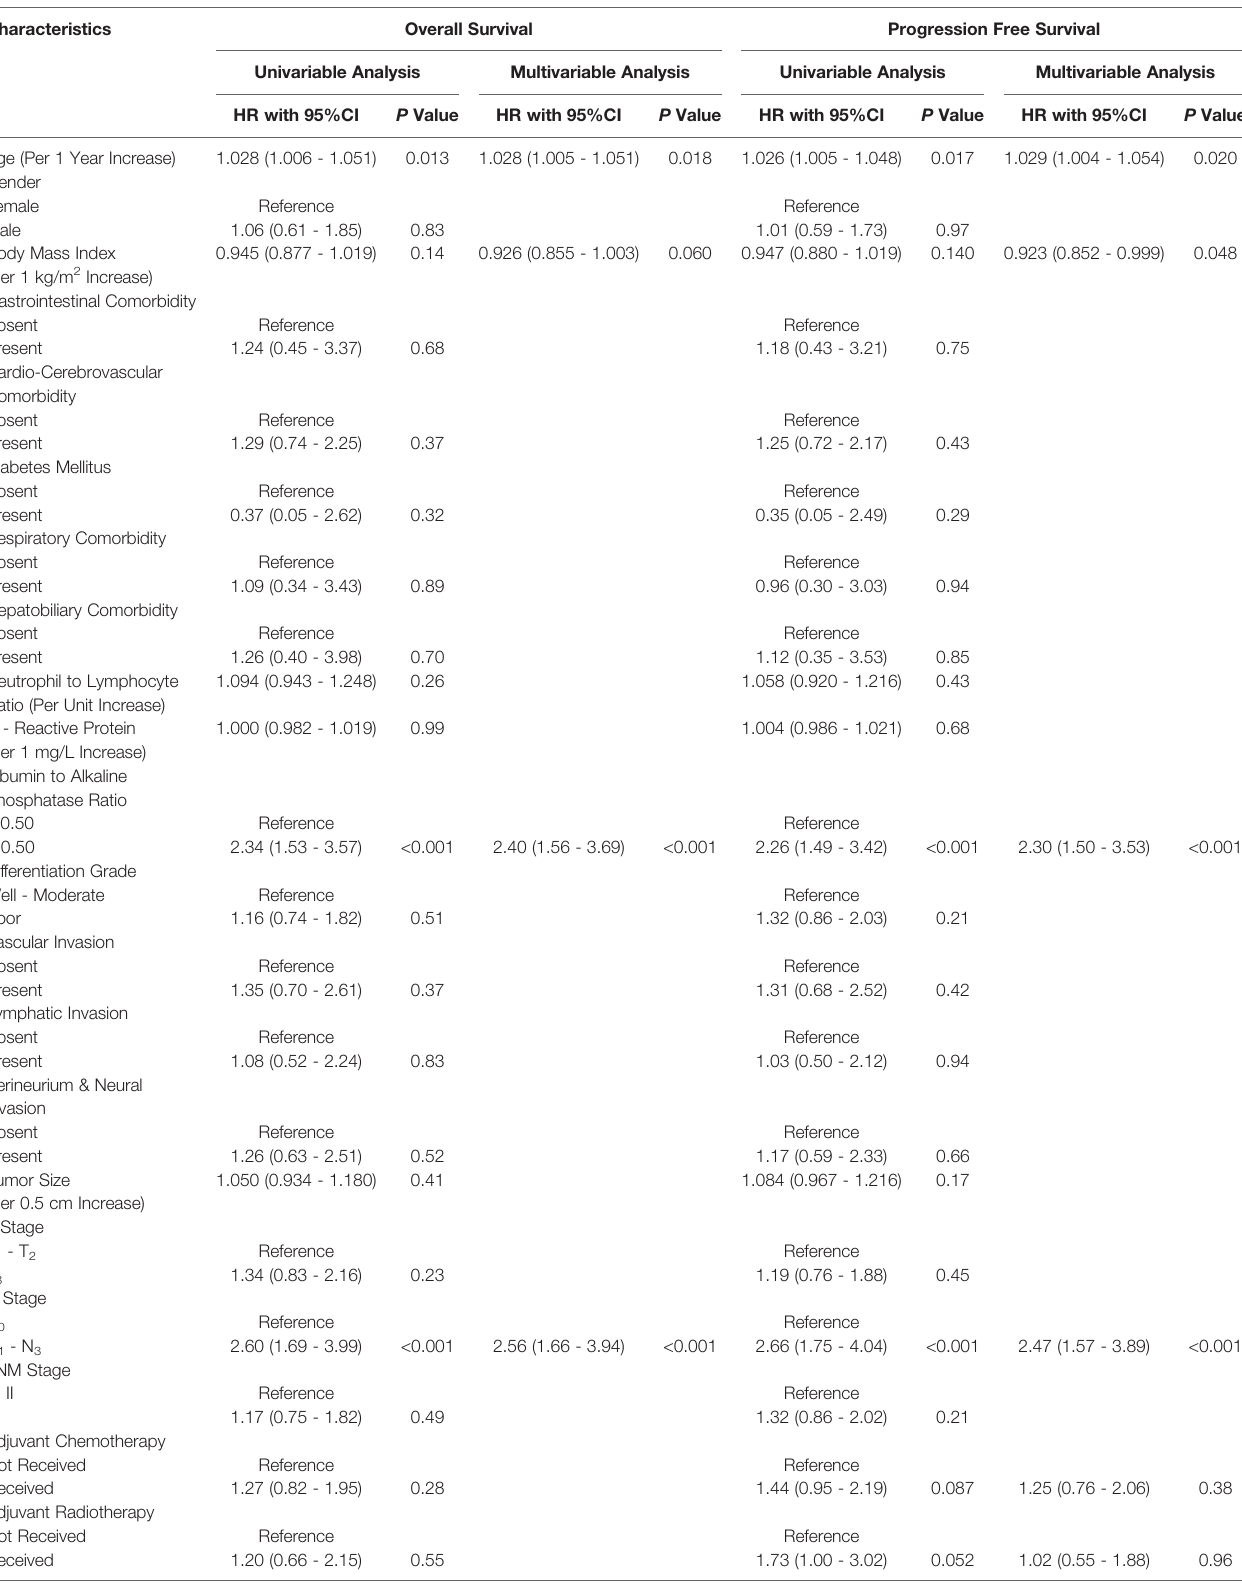
TABLE 4 | Univariable and multivariable analyses of the prognostic factors in the propensity score matched cohort.